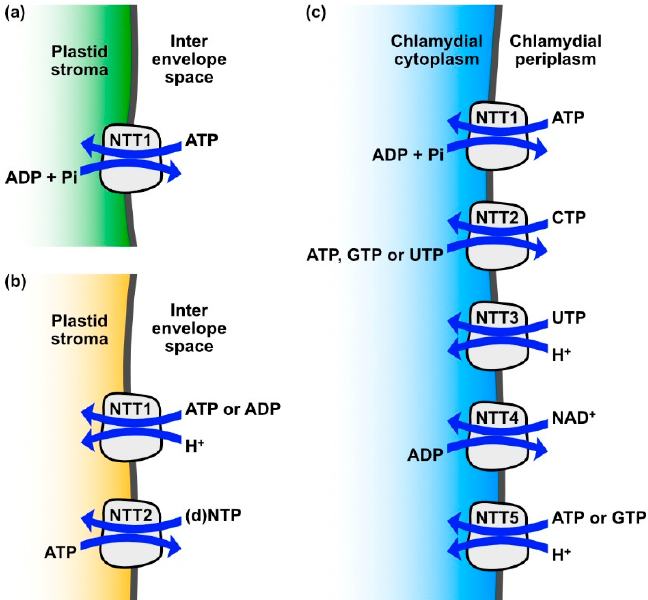
Figure 1. Transport activities of various nucleotide transporters (NTTs): ( a ) plant NTTs exchange adenosine triphosphate (ATP) against adenosine diphosphate (ADP) + inorganic phosphate (Pi) and thereby provide energy to the plastid when photophosphorylation is limited or not possible; ( b ) diatom NTT1 and 2 isoforms, in combination, facilitate net transport of a broad spectrum of nucleotides into the stroma ((d)NTP stands for the tested substrates cytidine triphosphate (CTP), guanosine triphosphate (GTP), deoxy-CTP (dCTP), ATP, uridine triphosphate (UTP), deoxy-GTP (dGTP), deoxy-ATP (dATP), thymidine triphosphate (TTP)); ( c ) in the environmental chlamydiae strain Protochlamydia amoebophila , NTT1 enables energy parasitism similarly to plant NTTs, whereas NTT2, 3 and 5 enable net nucleotide provision similar to NTT1 and 2 from diatoms and NTT4 allows the intracellular bacterium to extract nicotinamide adenine dinucleotide (NAD + ) from the host metabolism.